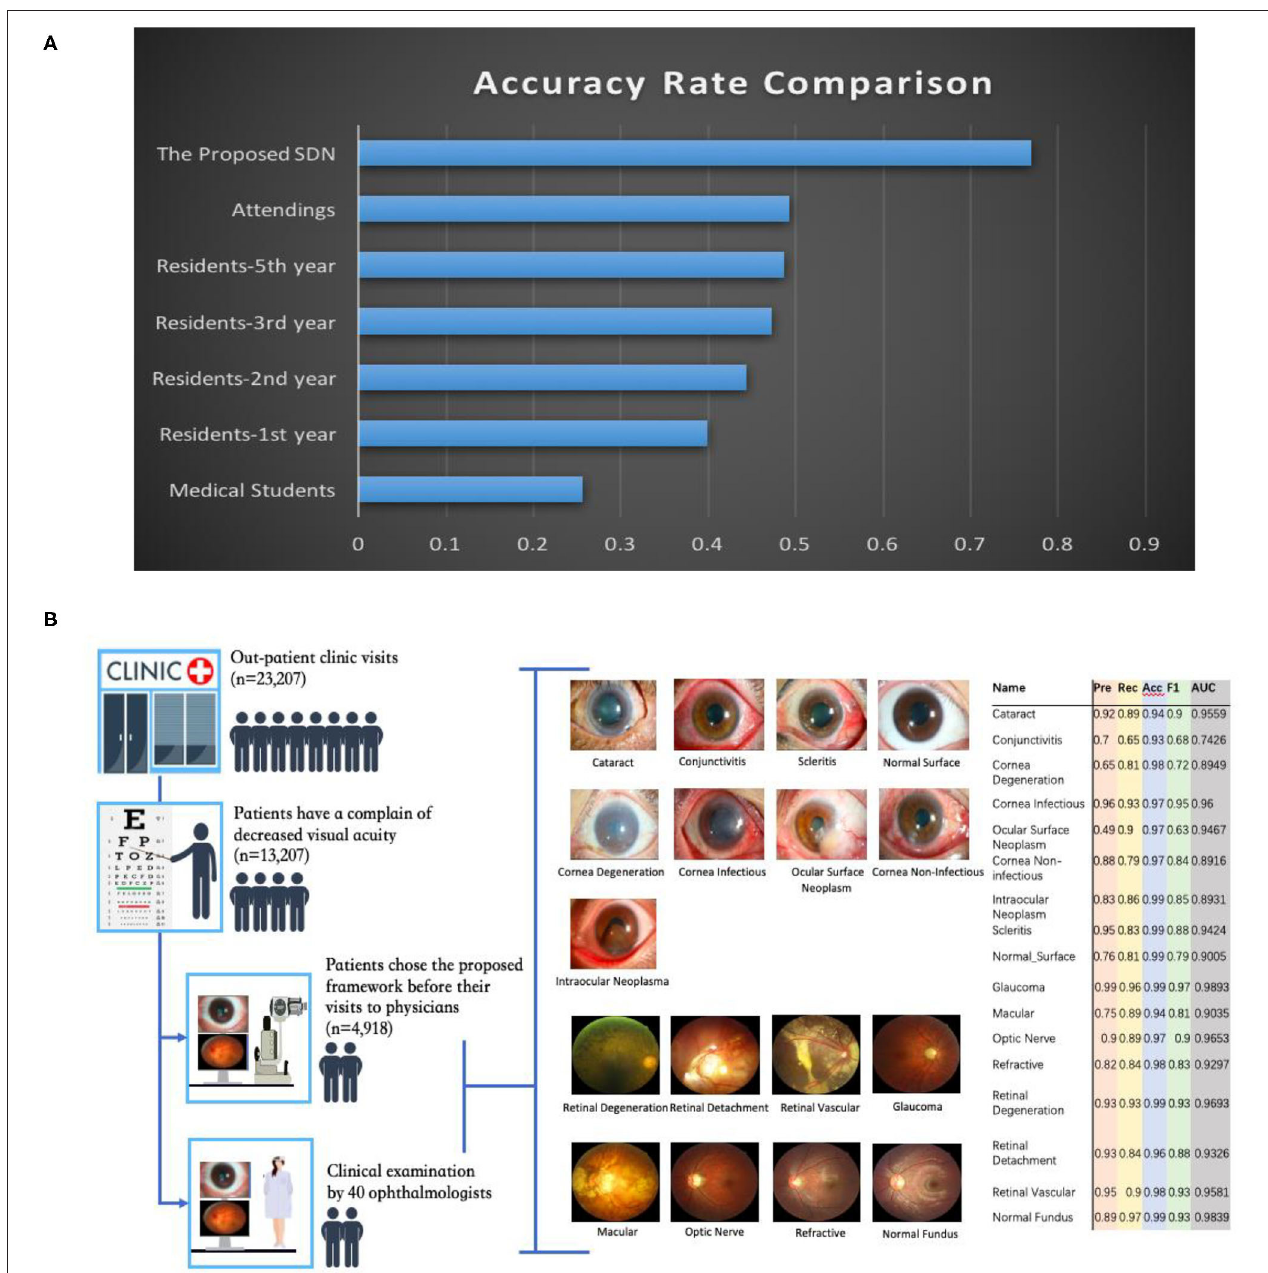
FIGURE 6 | Eye disease classification performance of the proposed hierarchical deep learning framework and ophthalmologists. (A) The proposed hierarchical deep learning framework was tested against 40 board-certified ophthalmologists in diagnosing the clinical cases of 13 patients in a real-world setting. For each image, the ophthalmologists were asked to make three diagnoses. The proposed hierarchical deep learning framework outperformed all levels of board-certified ophthalmologists for all cases. (B) Clinical application of the proposed hierarchical deep learning framework for visual impairment diseases in a tertiary eye center. Discrepancies between manual grades and the proposed hierarchical deep learning framework results were sent to an independent panel of senior specialists for arbitration.